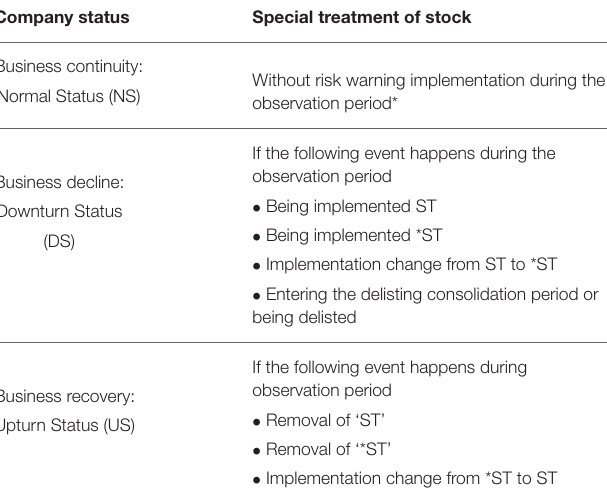
TABLE 1 | Three categories of listed company